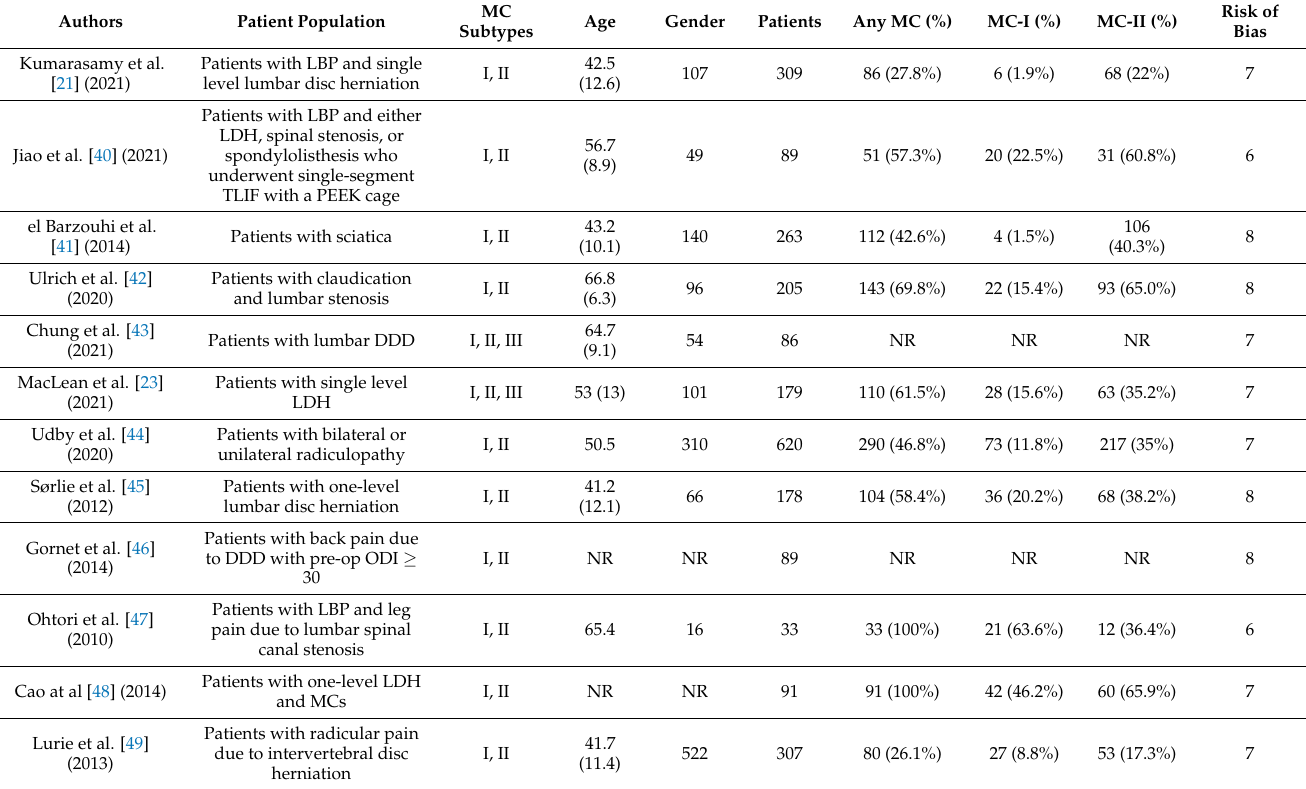
Table 2. The patient characteristics of studies evaluating the lumbar